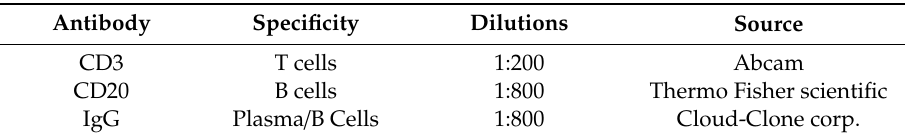
Table A1. Types of monoclonal antibodies used for IHC